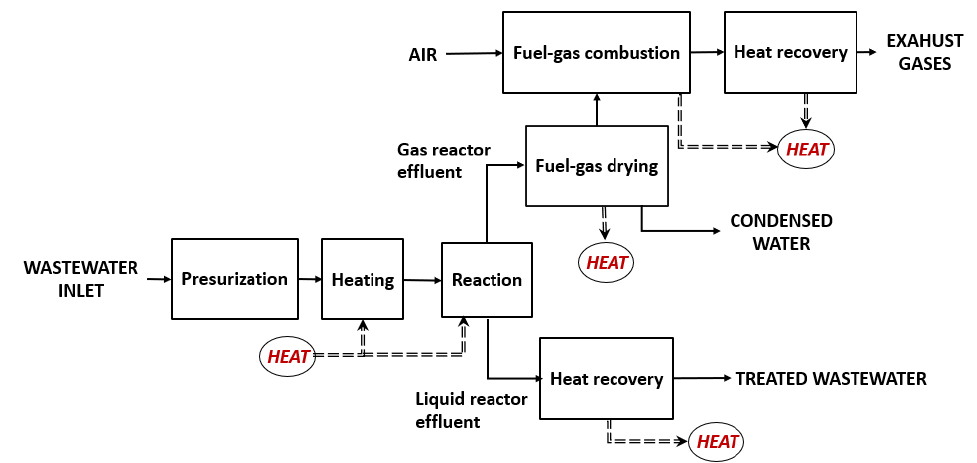
Figure 1. APR process block diagram.